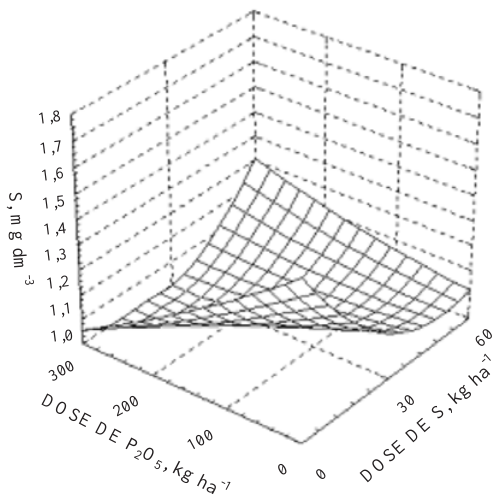
Figura 6. Concentração de enxofre no solo (dados transformados por 1 + x ) na profundidade de 0– 10 cm de acordo com a aplicação de doses de fosfato natural reativo e doses de enxofre. yˆ = 1,52359 – 0,0020035 * P – 0,0197619 ** S + 0,00017994 * S 2 + 0,0000461821 * PS (R 2 = 0,65 ** ). *, **